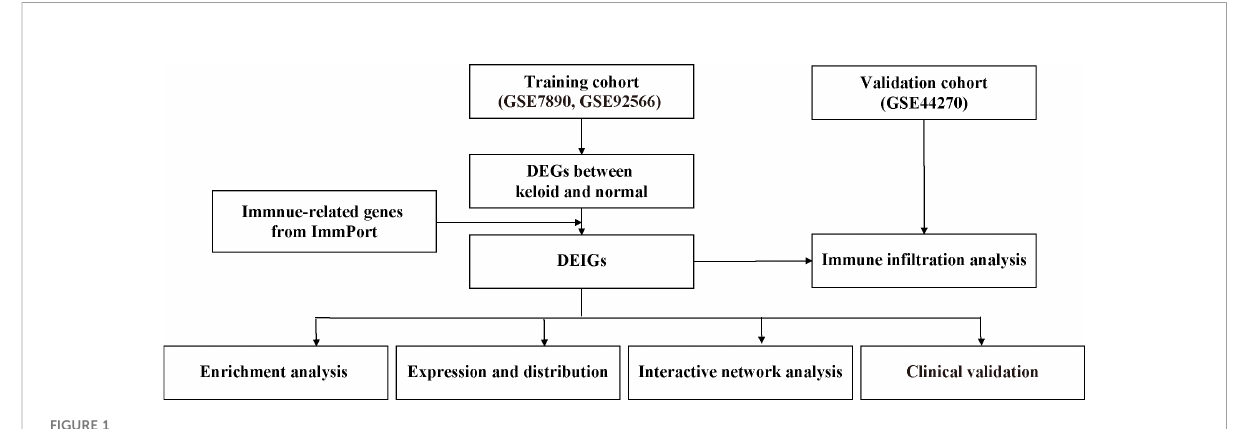
FIGURE 1 Design and work fl ow of this